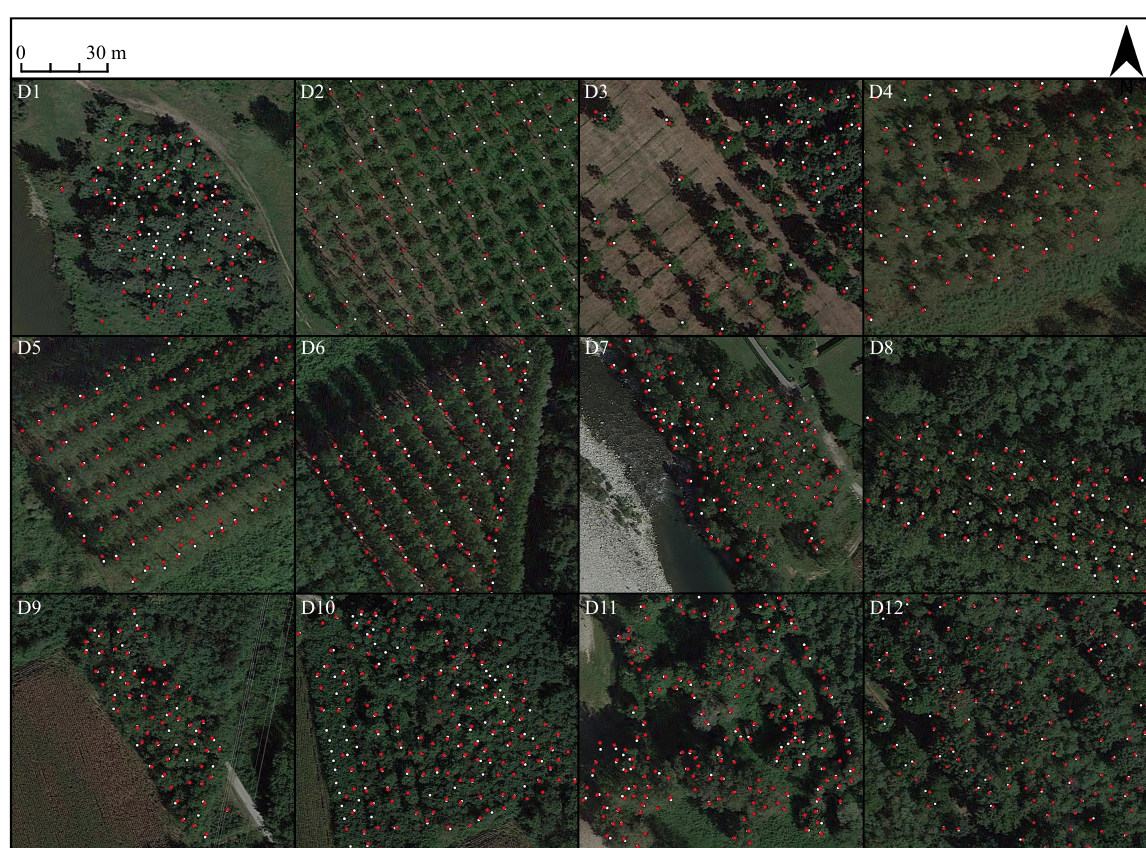
Figure 8. View of the twelve study areas from Google Earth. Red and white dots indicate the algorithm-derived and field measured stem locations,